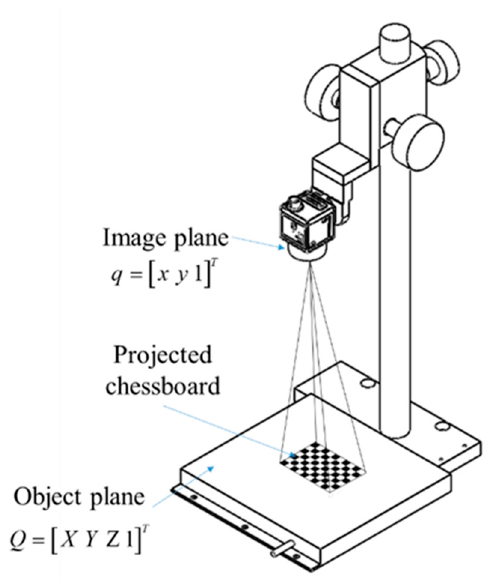
Figure 13. The schematic diagram of projected relation between the image plane and object plane in measurement mechanism (Figure 3b).